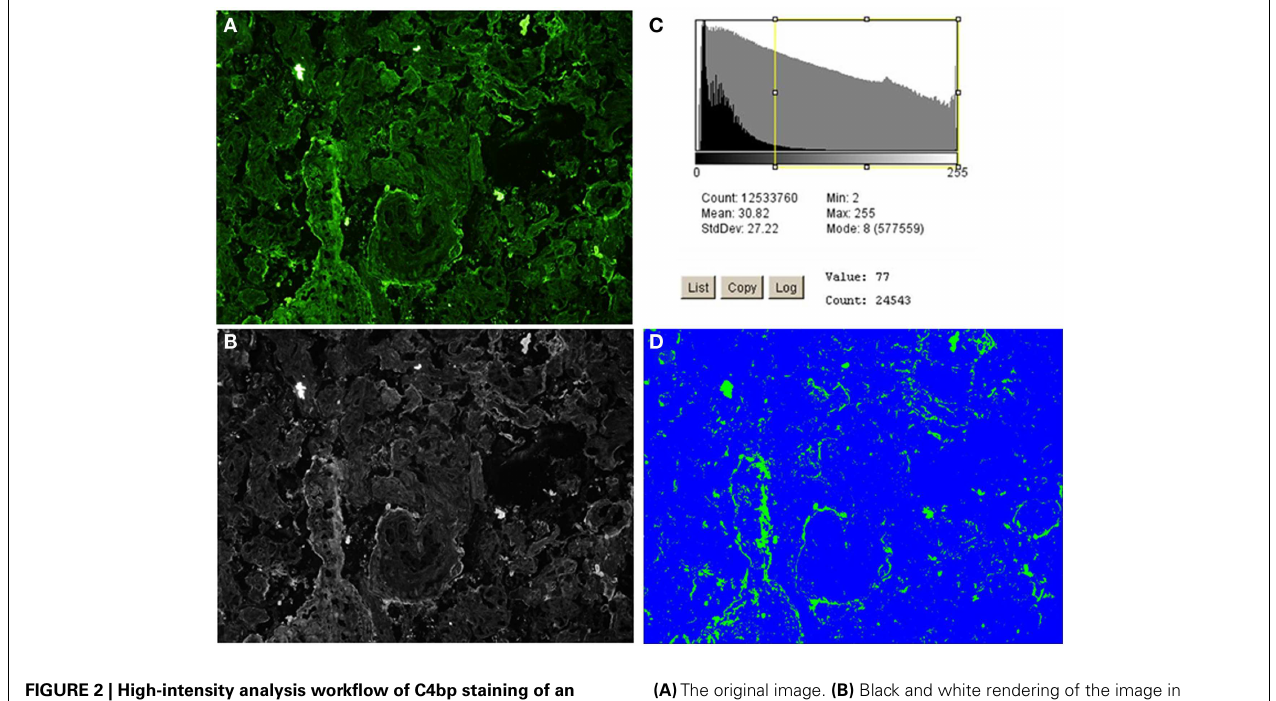
FIGURE 2 | High-intensity analysis workflow of C4bp staining of an early-onset preeclamptic placenta using ImageJ 1.46 software .The image is processed through steps (A–D) to produce a quantification of the high-intensity fluorescence areas, which correspond to the structures where (C) deposition/expression is most conspicuous.